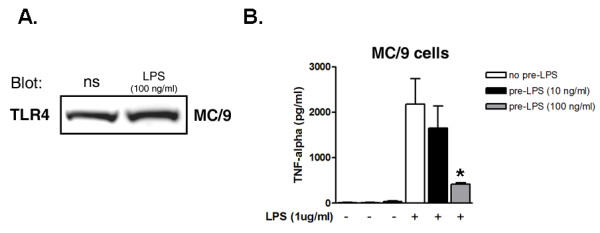
Effect of LPS prestimulation on expression of TLR4 and on TNFα production. The MC/9 mast cell line was prestimulated with LPS (10 and 100 ng/ml) and the expression of TLR4 (A) and the production of TNFα after a second challenge with LPS (1 μg/ml) (B) were determined by immunoblotting and ELISA, respectively. The production of TNFα was significantly reduced in a dose-dependent manner after prestimulation with LPS 100 ng/ml (* p < 0.01). However, this reduction was not mediated by a reduction in TLR4 expression, as shown. Values are mean and SEM from 3 independent experiments.